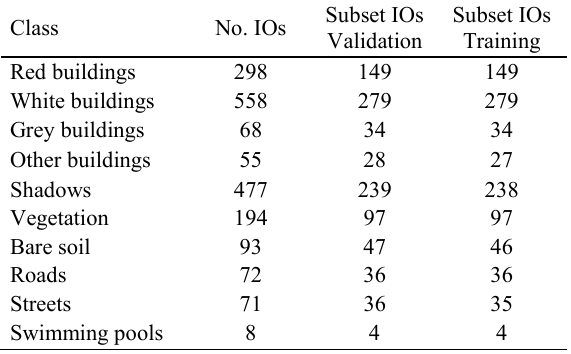
Table 1. IOs after the segmentation process.